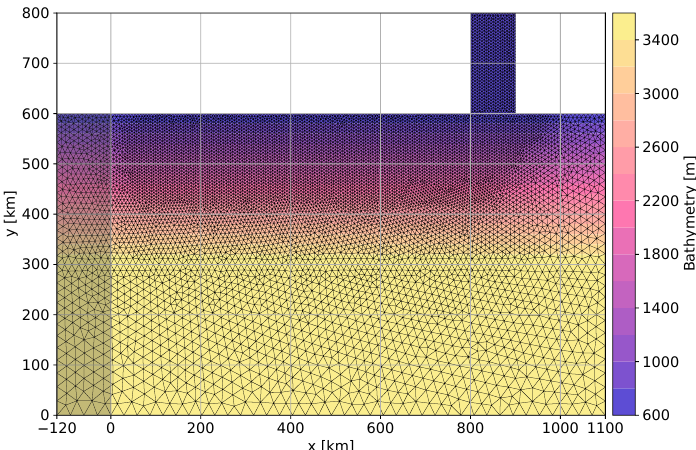
Figure 8. Horizontal mesh and bathymetry for the DOME test case. The domain is extended 120km further to the west to avoid boundary ef- fects (shaded region). Horizontal element size ranges from 6 to 22km. There are 18 . 8 distributed vertical levels resulting in 450